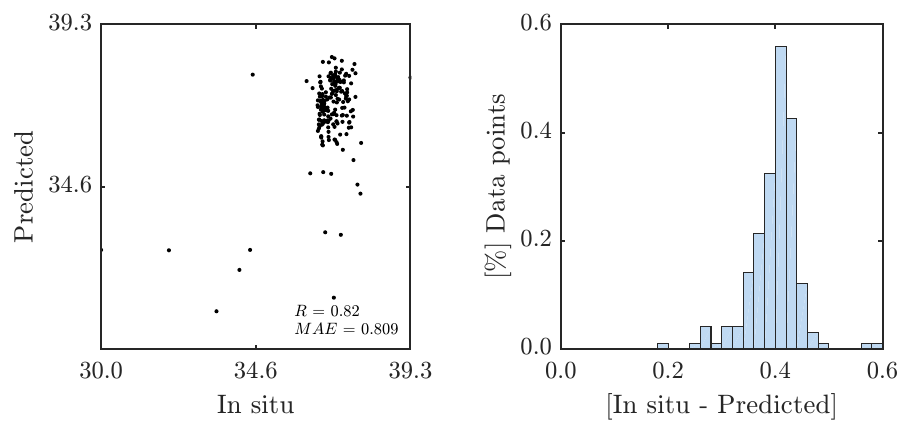
Figure 11. Temperature extrapolation. Test : predicted and in situ data time series ( top ); predicted vs. in situ data ( bottom left ); histogram of residuals ( bottom right ). Units of temperature are ◦ C.